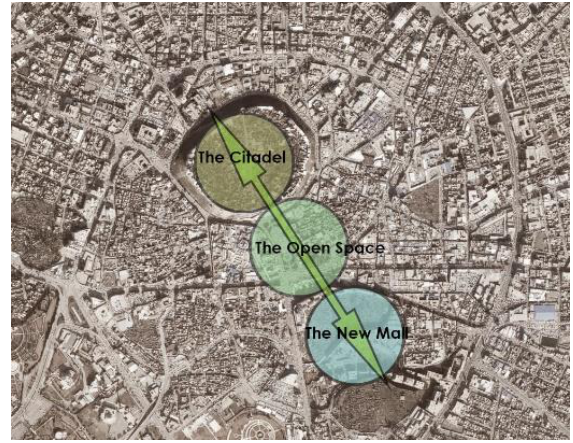
Figure 2. New Centers near the citadel pushing out Source Developed by the author.